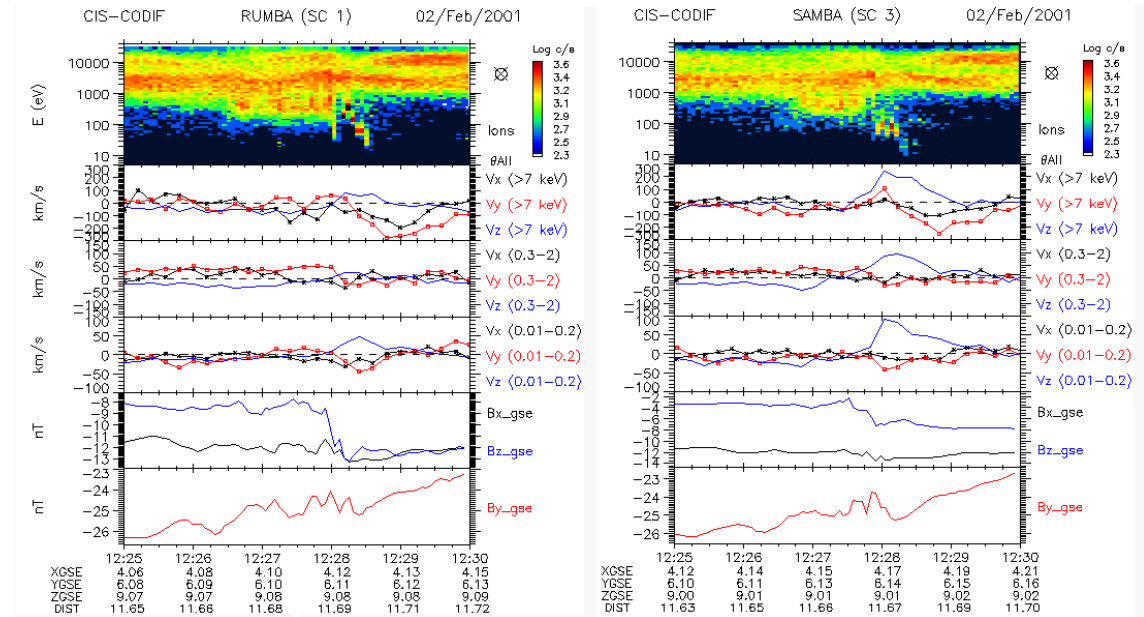
Fig. 5. A PTE (2 February 2001) with fully “mixed” plasma. No anti-sunward flow is observed in this PTE, indicating that the structure is stagnant yet with signs of activity as evidenced by the electric drift at the boundary and the field-aligned current signature (see text). The IMF: B z ≈ 3nT, B y ≈ 0nT.